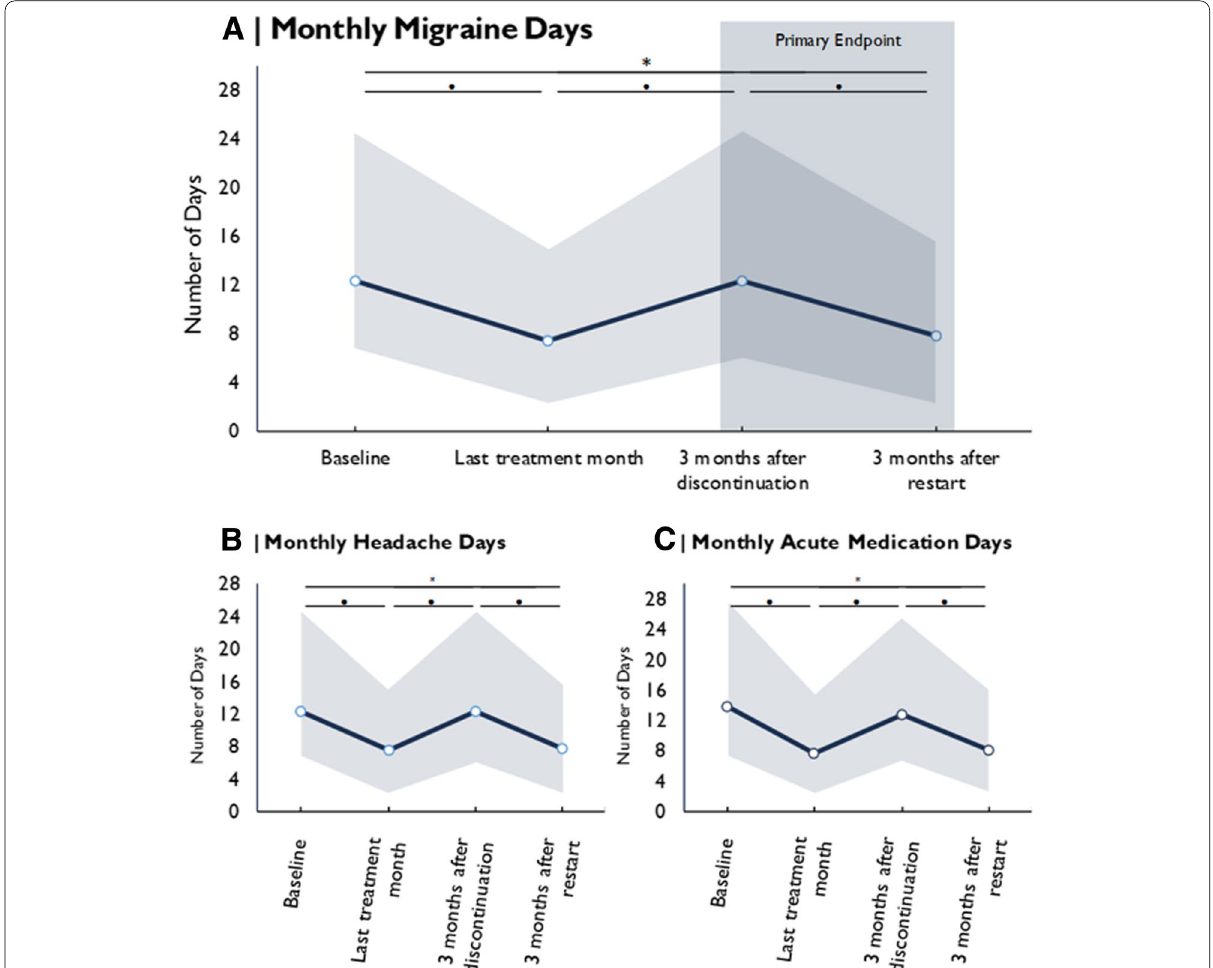
Fig. 2 Migraine evolution before and after resumption of preventive treatment with CGRP(-receptor) mAbs. Evolution of monthly migraine days ( A ), monthly headache days ( B ), and monthly days with acute medication use ( C ) before the first mAb treatment cycle (baseline), at the end of the first treatment cycle, in the third month of treatment discontinuation and in the third month after restart. Values are mean ● = statistically significant between timepoints. * = statistically significant accross timepoints. Grey square = primary